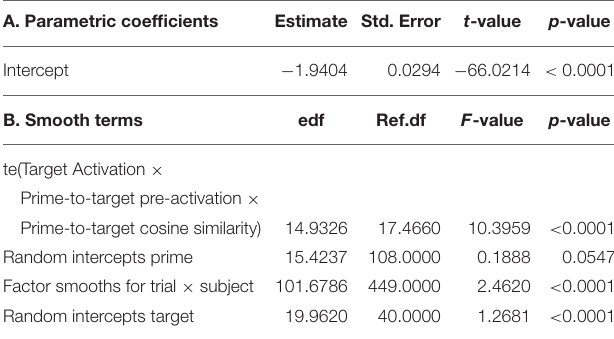
TABLE 5 | GAMM fitted to inverse transformed reaction times using model-based predictors; te(): tensor product